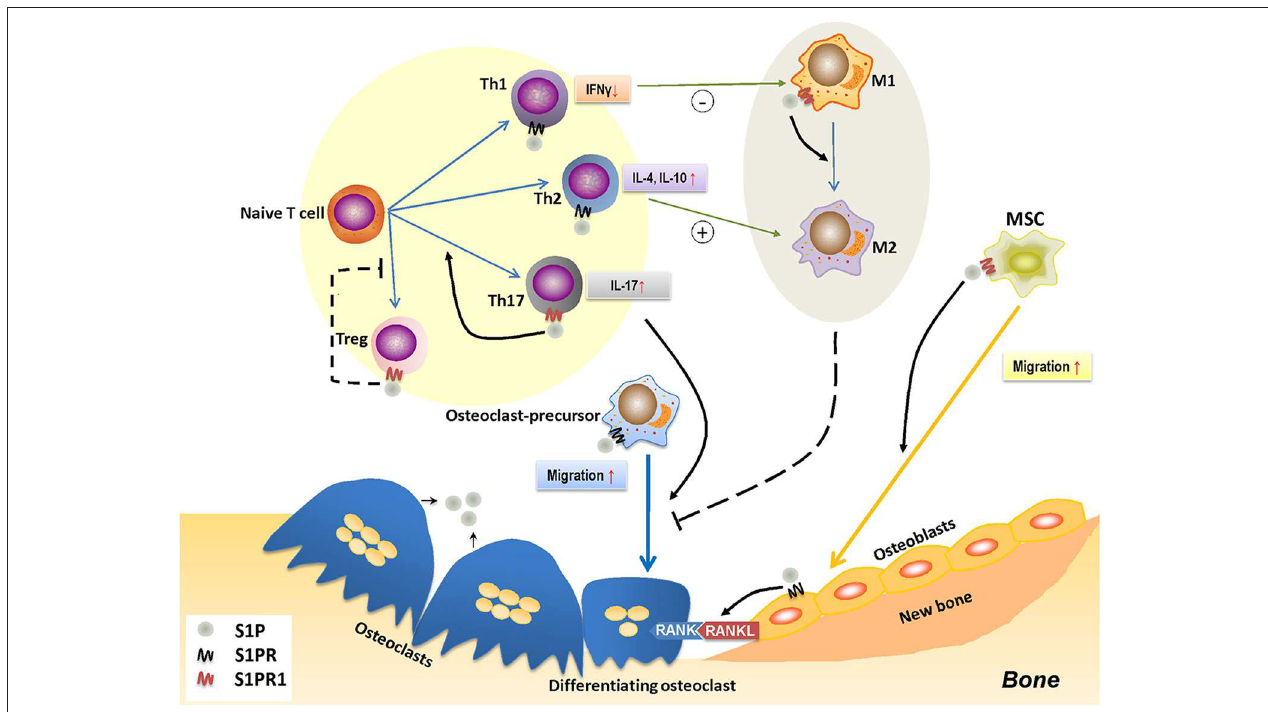
FIGURE 3 | The role of S1P-S1PR1 signaling in osteoimmunology. S1P-S1PR1 signaling is greatly involved in the interaction between immune system and bone remodeling. On one hand, S1PR1 directly affects osteoclastogenesis by inducing the migration of osteoclast-precursors. The direct effect of S1P on osteoclast-precursors results in reduced osteoclastogenesis; however, it induces RANKL production of osteoblasts and facilitating the RANKL-RANK mediated osteoclastogenesis. S1P also induces the migration of MSCs and osteogenesis by activating S1PR1. On the other hand, S1P-S1PR1 signaling participates in immune regulation, which affects the polarization and function of T-helper cells. S1P-S1PR1 signaling induces the differentiation and function of Th17 cells (known as inducing osteoclastogenesis) while impedes that of Treg cells (known as reducing osteoclastogenesis); therefore facilitating osteoclastogenesis. S1P also induces the function of Th2 cells while reduces that of Th1 cells, which affects the macrophage phenotype; also, S1P directly induces the transition of M1 to M2 phenotype by activating S1PR1. This conversion of pro-inflammatory M1 macrophages to tissue-engineering M2 macrophages therefore impedes osteoclastogenesis, which might also